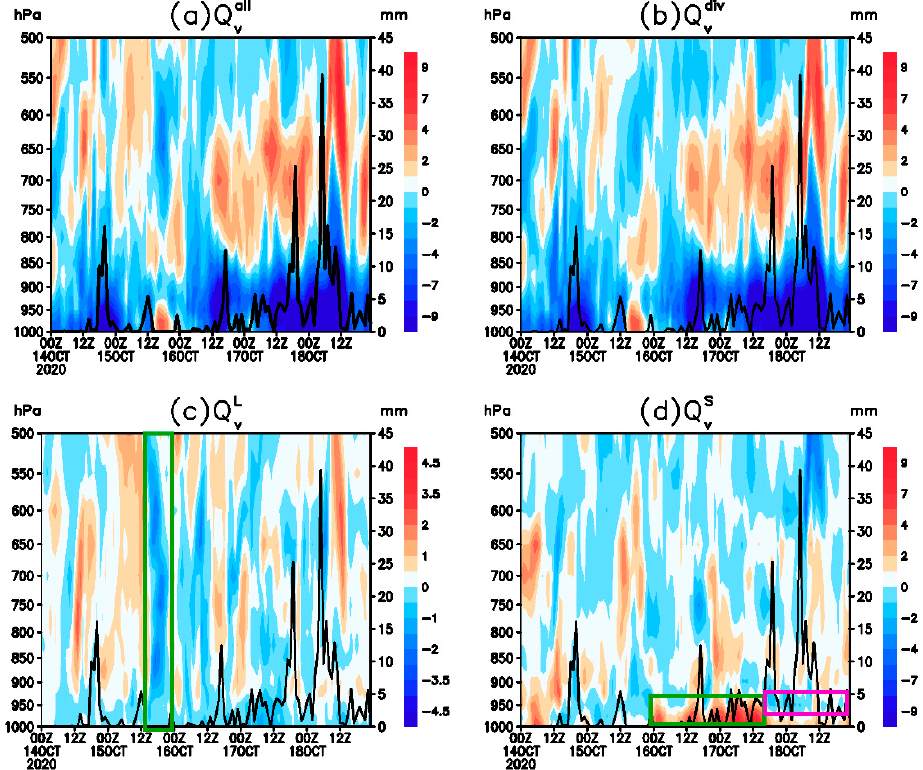
Figure 7. Pressure-time cross sections of domain averaged ( a ) Q vall , ( b ) Q vdiv , ( c ) Q vL (shaded, units: 10 − 7 g · hPa − 1 · cm − 2 · s − 1 ), and ( d ) Q vS (d, shaded, units: 10 − 8 g · hPa − 1 · cm − 2 · s − 1 ) over the south coast (blue rectangle in Figure 1d) superimposed with hourly precipitation (units: mm · h − 1 ), for Sanya (blue triangle in Figure 1d).